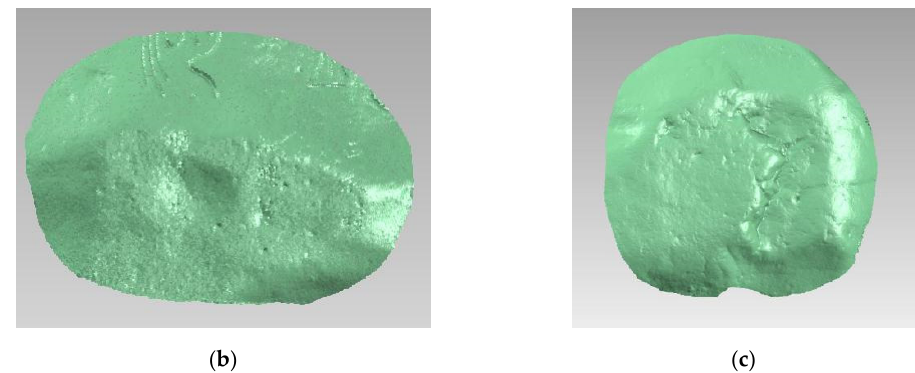
Figure 5. I-point of each experimental data: ( a ) I-point of the statue; ( b ) I-point of S-LS; ( c ) I-point of NS-LS.